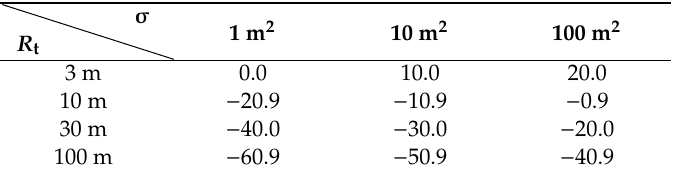
with a constant RCS and specific ranges.